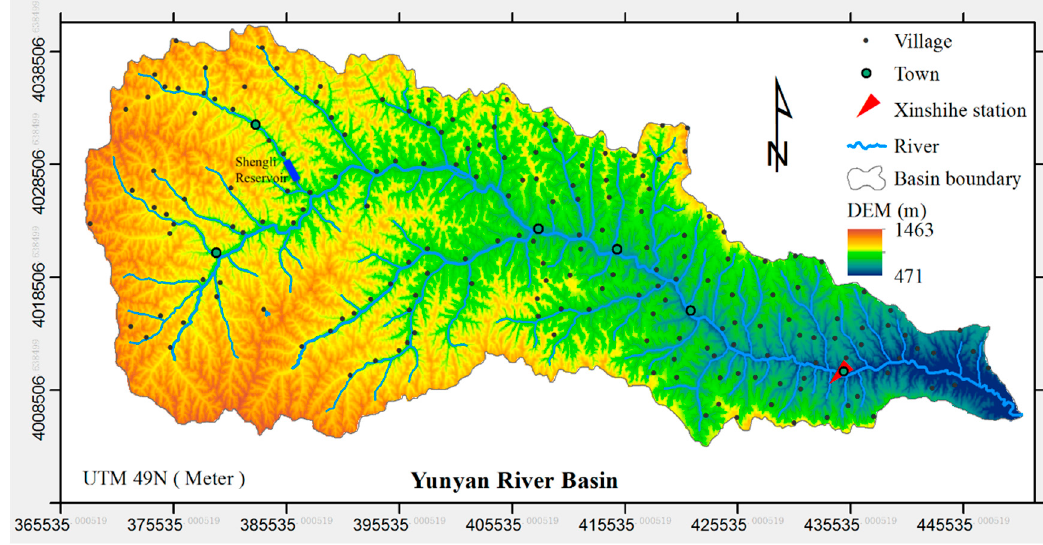
Figure 1. Map of the Yunyan River Basin.